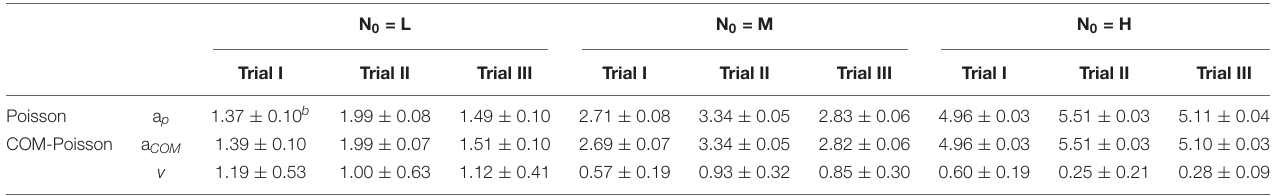
TABLE 1 | The Poisson and the COM-Poisson distribution parameters (a P , Poisson; a COM , COM-Poisson, ν COM-Poisson) of the observed initial bacterial cell counts (LnN 0 : Ln CFU/0.2 mL) in the three trials.